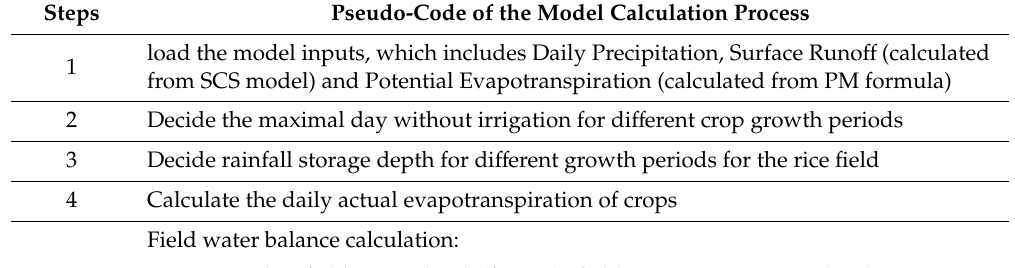
Table 1. Main steps and Pseudo Code for the irrigation simulation